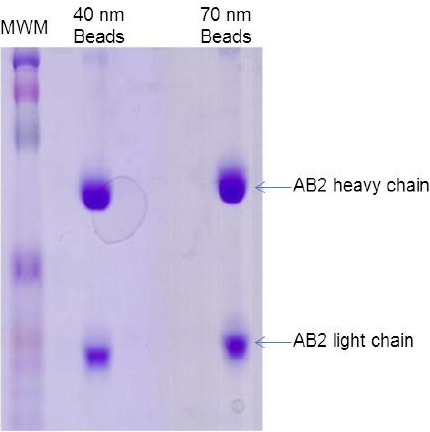
Figure 4. Adsorption of AB2 to gold nano beads: 40 and 70 nm gold beads were incubated with AB2 and resolved by SDS-PAGE. (MWM = Molecular weight